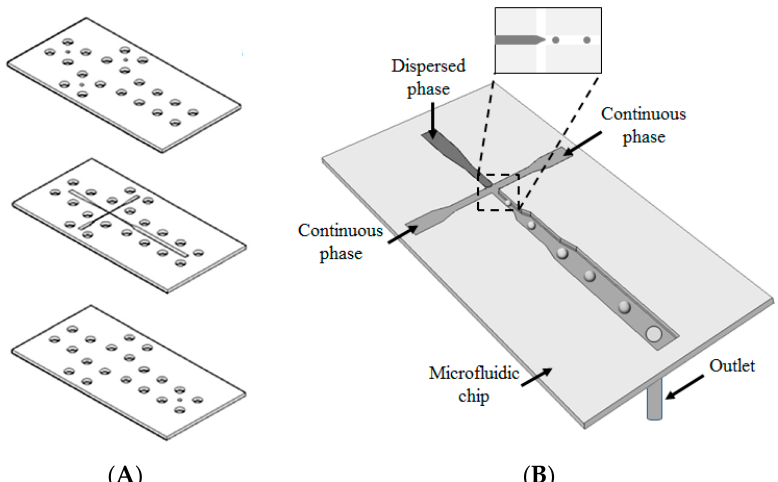
Figure 1. ( A ) Microfluidic chip under an expanded view, and ( B ) schematic drawing of microchannel design. The cross-junction microchannel design could exert a focusing force if two immiscible streams converged, and uniform self-assembling spheres could be obtained subsequently. The broadened channel design in the downstream is used to reduce the flow rate of fluids, and then it can enhance the real-time observation of droplet formation and transportation by a microscope.